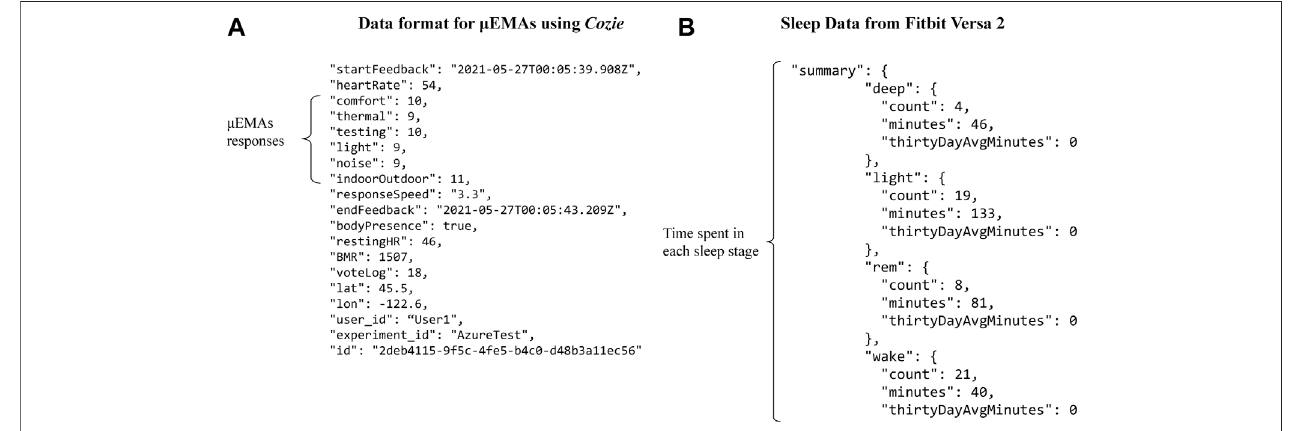
FIGURE 3 | Example μ EMA responses and ancillary data from the Cozie clockface (A) , and sleep quality data (B) .